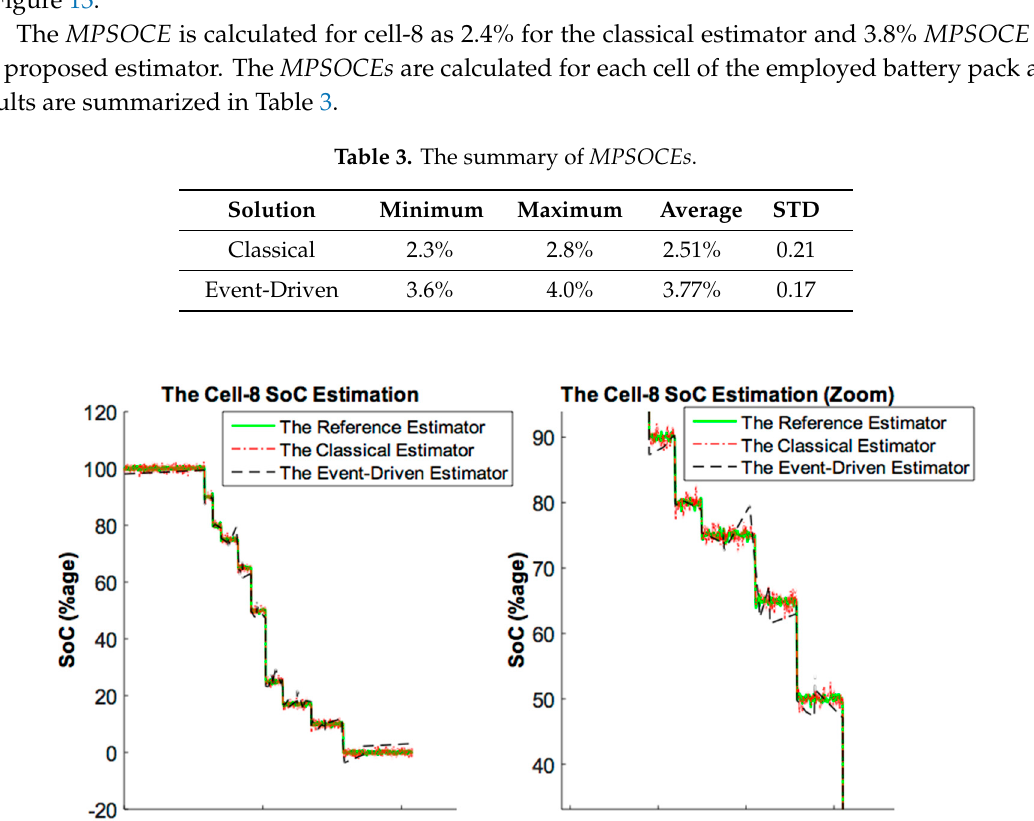
Table 3. The summary of MPSOCEs.